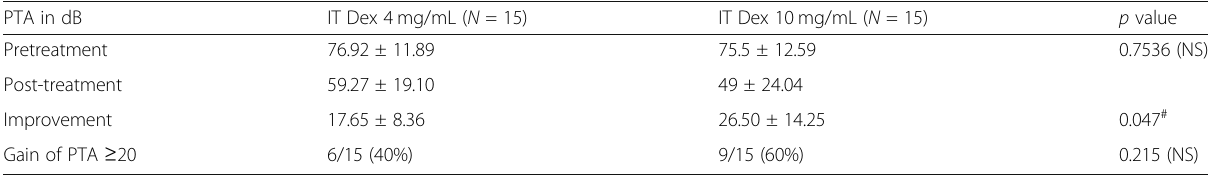
Table 2 Pretreatment, post-treatment and gain of PTA in dB in both groups PTA in dB IT Dex 4 mg/mL ( N = 15) IT Dex 10 mg/mL ( N = 15)